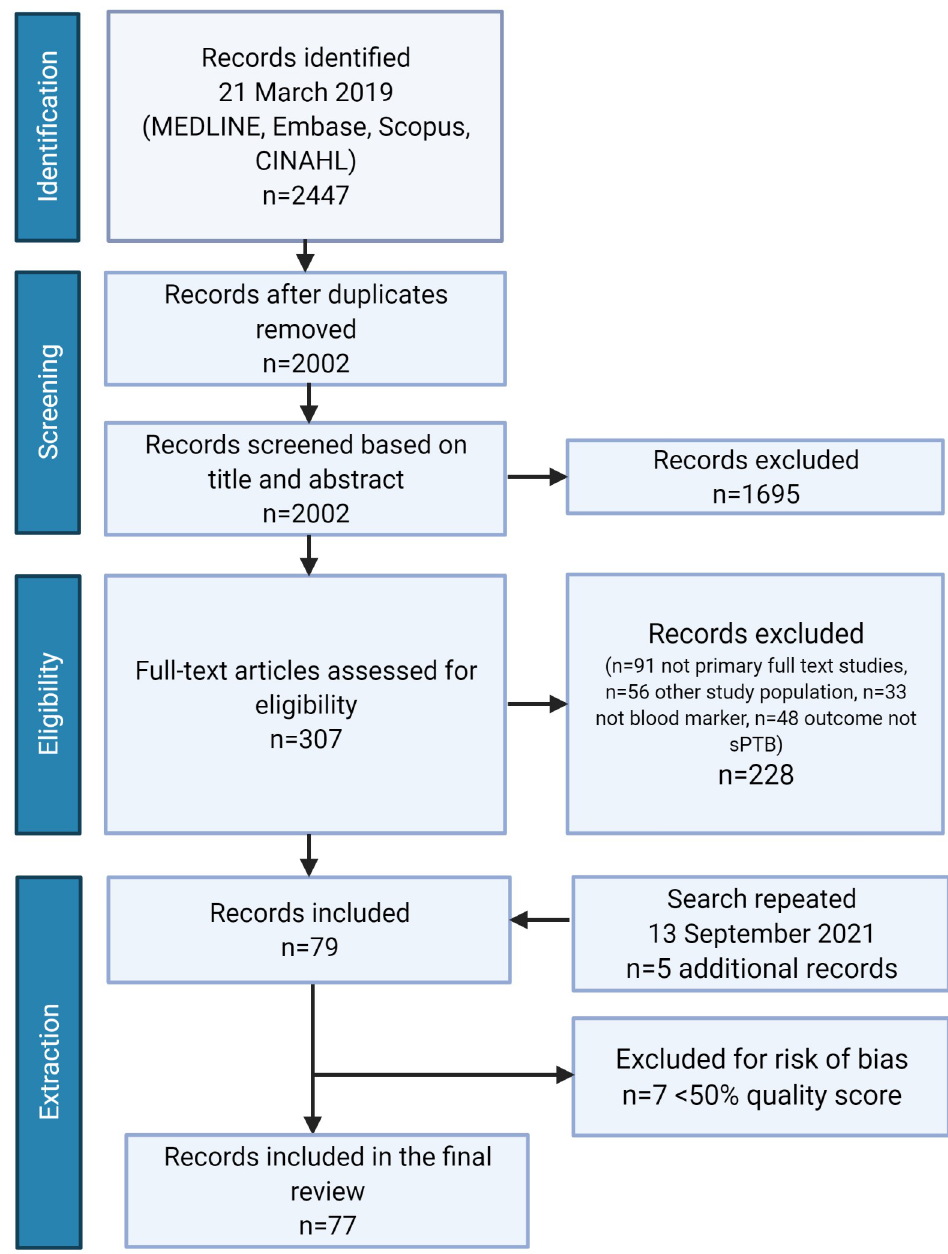
Fig 1. PRISMA flow diagram. Article identification, screening, and eligibility selection for systematic review of maternal blood markers associated with subsequent sPTB. Created with